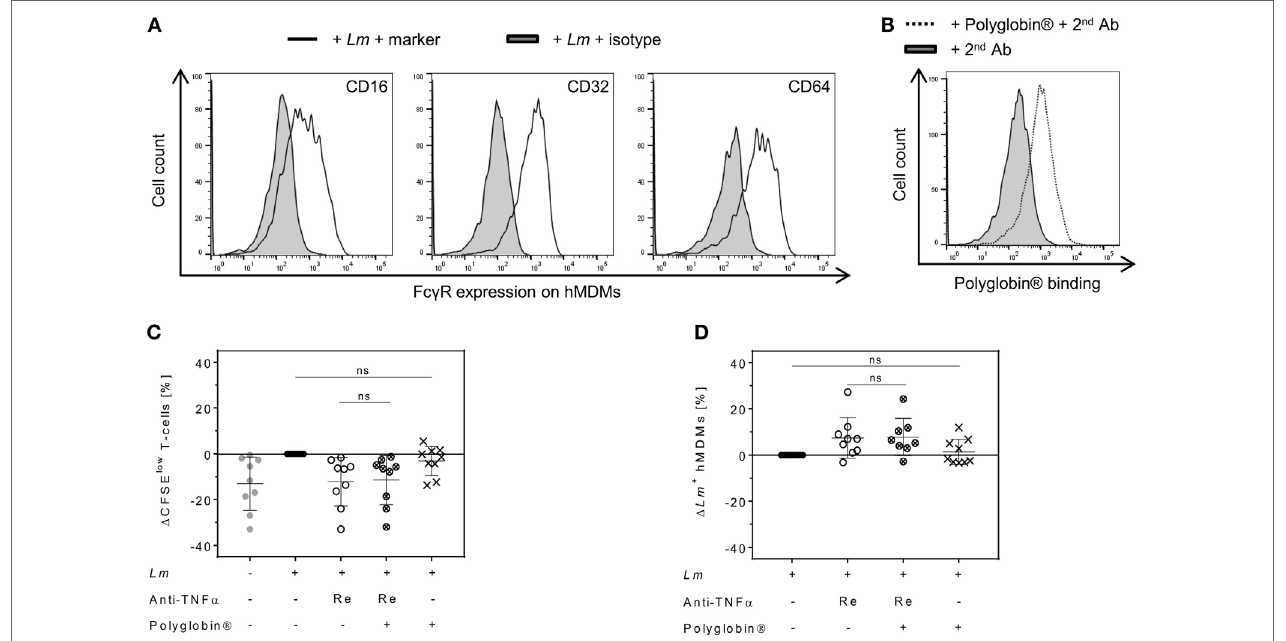
FigUre 6 | Reduced T-cell proliferation and increased Leishmania major ( Lm ) infection rates upon soluble TNF α (sTNF α ) blockade by Remicade ® are independent of fragment crystallizable (Fc)–Fc γ receptor (Fc γ R) interactions. (a) Representative histograms of flow cytometry analysis show Fc γ R expression (black line) on infected human monocyte-derived macrophages (hMDMs) in comparison to the isotype control (black solid) 24 h after Lm infection. (B) 7 days after infection, binding of Polyglobin ® Abs to Fc γ Rs on Lm -infected and Polyglobin ® -treated hMDMs (black dotted line) in comparison to non-treated cells (black solid) was confirmed by flow cytometry using anti-human IgG staining. (c,D) Lm -infected ( ● ) or non-infected ( ● ) macrophages were pre-incubated with or without Polyglobin ® after which peripheral blood lymphocytes and Remicade ® (Re) were added (Remicade ® ○ ; Polyglobin ® × ; Remicade ® + Polyglobin ® ⊗ ). (c) T-cell proliferation and (D) infection rates in hMDMs of co-cultures were assessed by flow cytometry 7 days post-infection. Values are illustrated as differences to the untreated control of the same donor. Results are presented as mean ± SD ( n ≥ 8) and were obtained from at least three independent experiments. Statistical analysis was carried out using the Wilcoxon signed-rank test. ns P >